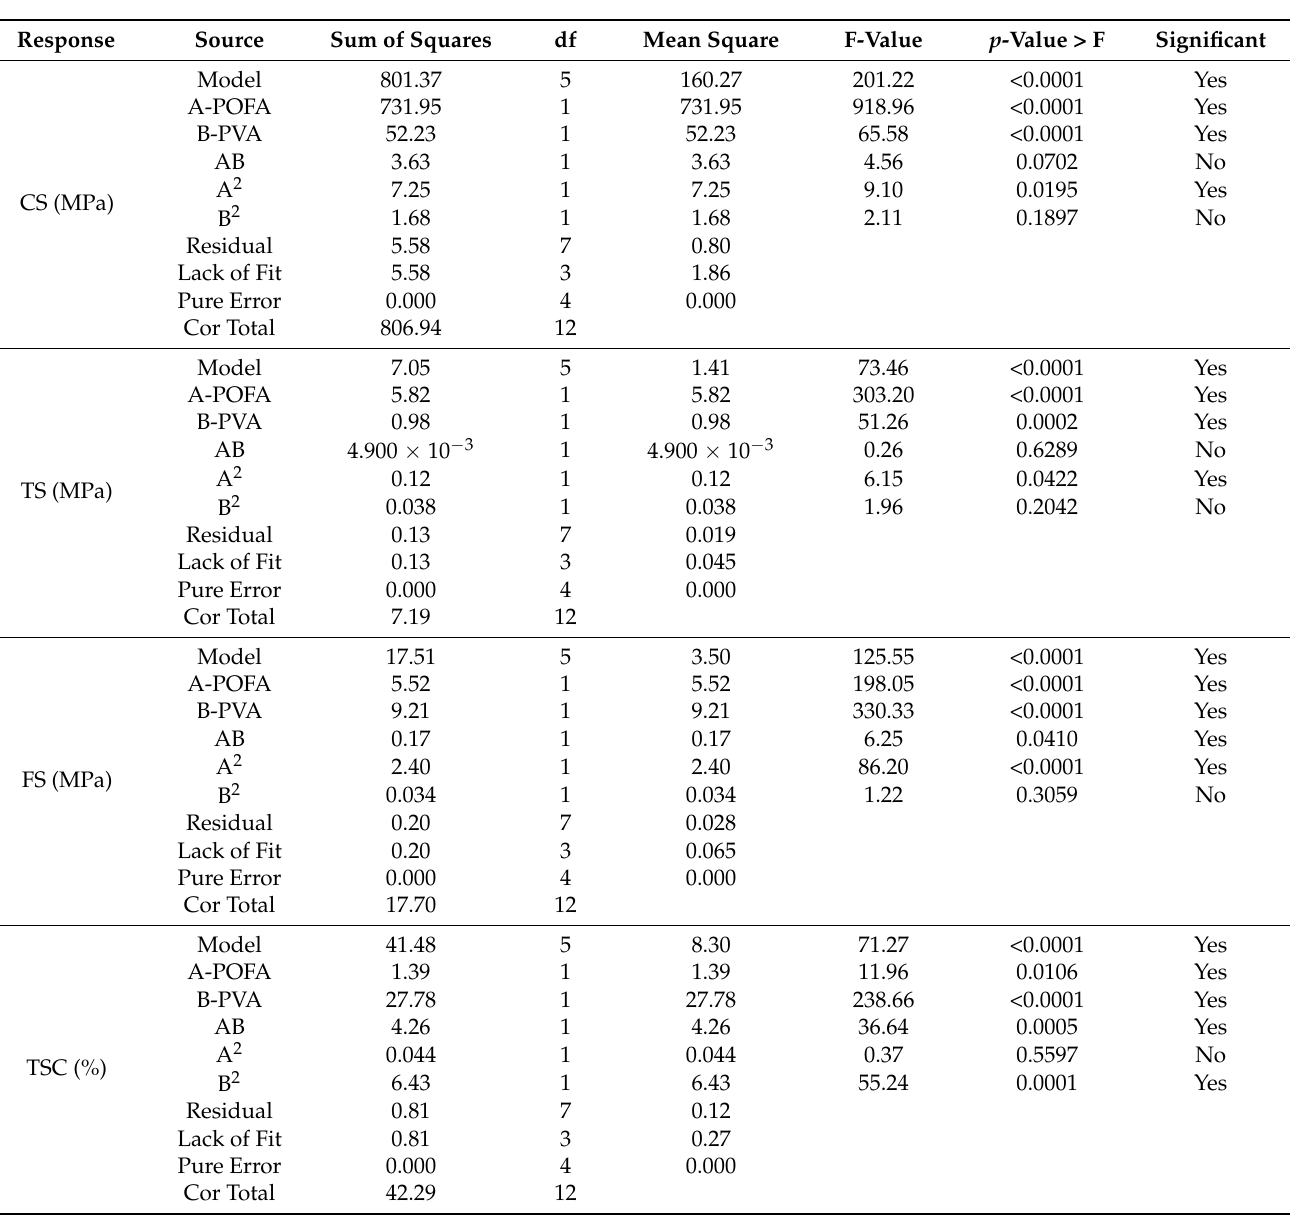
Table 5. Result of